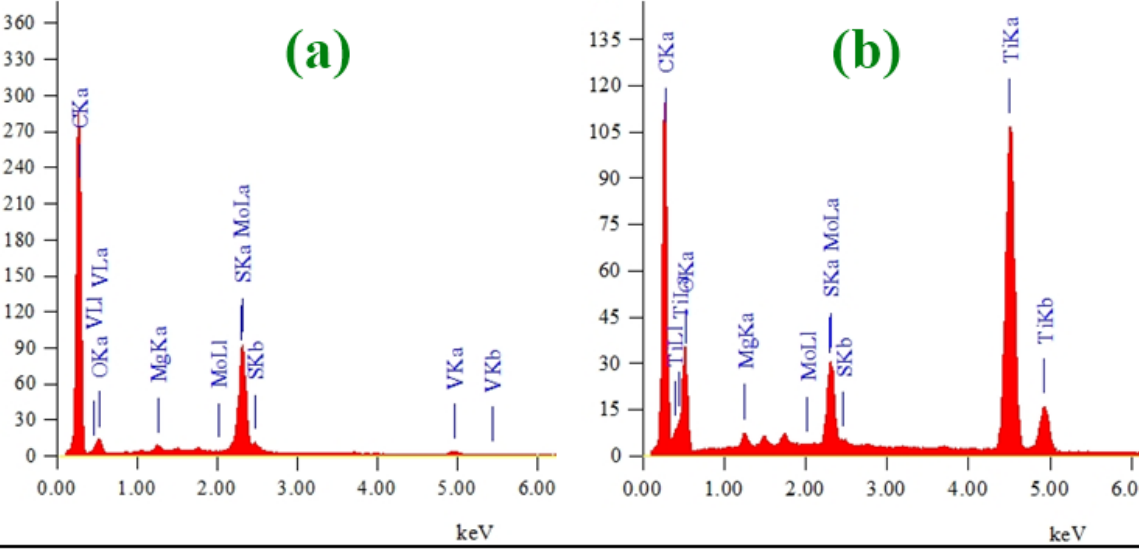
Figure 4. EDX spectra of ( a ) original FA and ( b ) FA-TiO 2 nanocomposite.